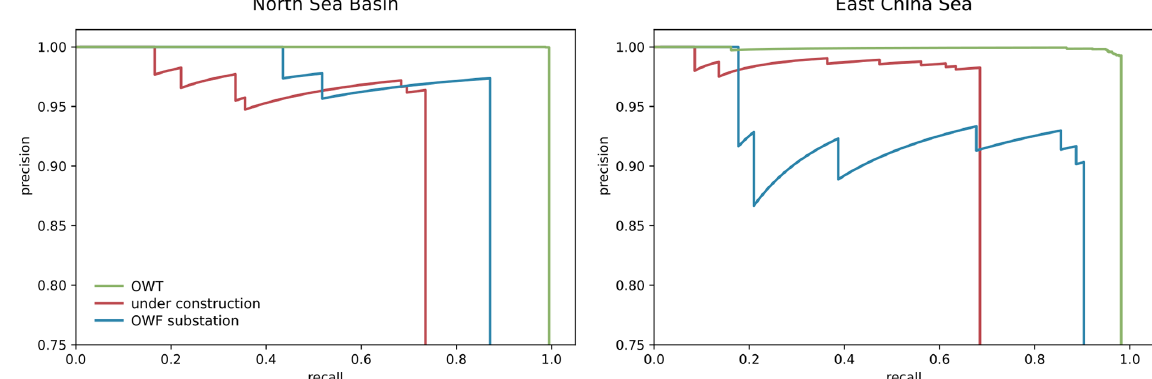
Figure 9. Precision–recall curves for the CNN cascade detections on the 2021Q2 global Sentinel-1 median composite for each respective class. The detections were evaluated with the 2021Q2_nsb (North Sea basin) and 2021Q2_ecs (East China Sea) ground truth data sets. The AP values from Table 2 are the corresponding areas under the interpolated precision–recall curves.